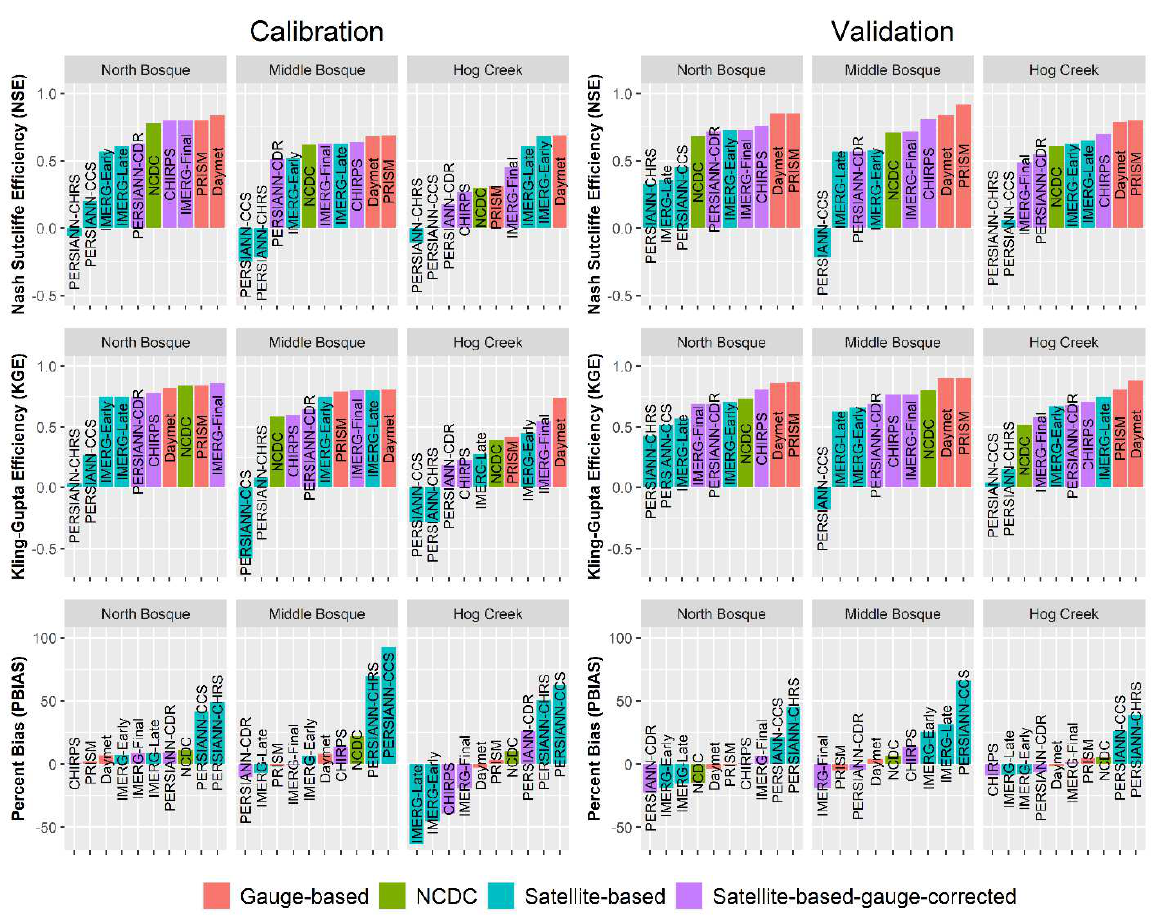
Figure 6. SWAT model performance statistics using gridded precipitation datasets for calibration and validation with monthly streamflow data. validation with monthly streamflow